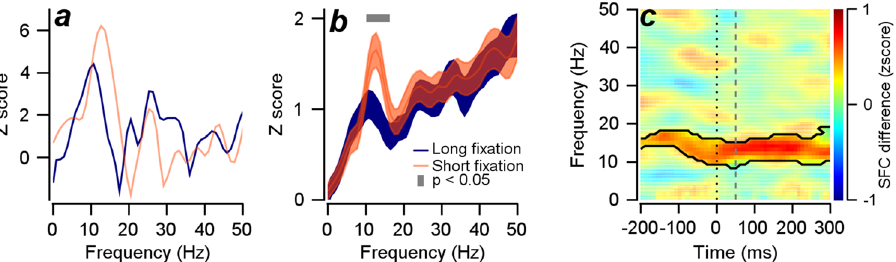
Figure 4. A spike-field coherence analysis. ( a ) Z scored spike-field coherence analysis for an example neuron. Orange color denotes the short fixation duration condition, and blue denotes the long fixation duration condition. ( b ) Z scored spike field coherence analysis for the 130 neurons. The gray rectangle shows the frequency when the two conditions are significantly different at the p value of 0.05. The shaded areas show the standard errors. ( c ) Z scored spike-field coherence analysis for the 130 neurons across different times. The black contour shows the significant time and frequency where zSFC in the short fixation duration was significantly higher than zSFC in the long fixation duration (cluster-based permutation test, p = 0.05). The black dotted line shows the timing for motion onset, and the gray dashed line shows the time window for the data in Fig.